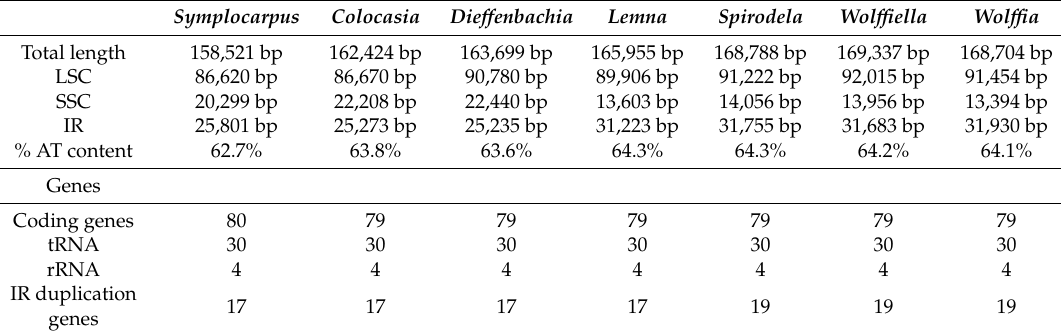
Table 1. General features of Symplocarpus and comparison to other Araceae species. Symplocarpus Colocasia Dieffenbachia Lemna